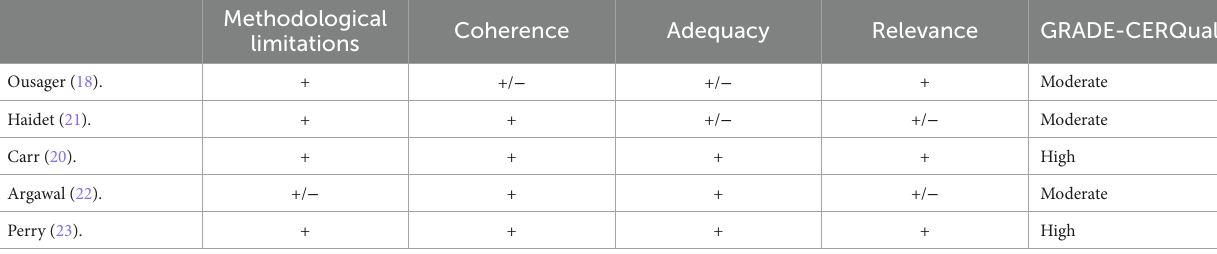
TABLE 3 Quality appraisal of the systematic reviews (AMSTAR) (Spain, 2022). 1 2 Remein (19). Y N N P Y Y N N Very low Hoang